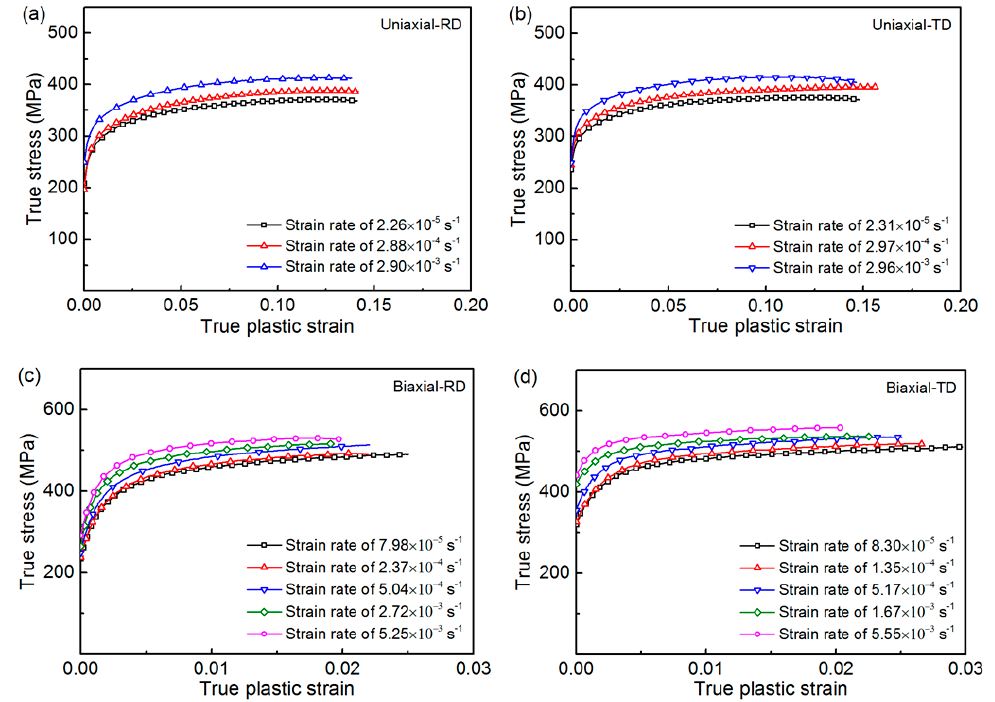
Figure 11. True stress-plastic strain curve of CP-Ti at various strain rates: ( a ) uniaxial RD, ( b ) uniaxial TD, ( c ) biaxial RD, ( d ) biaxial TD.